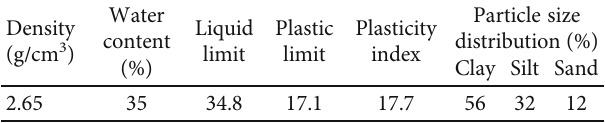
Table 1: Basic index properties of the tested